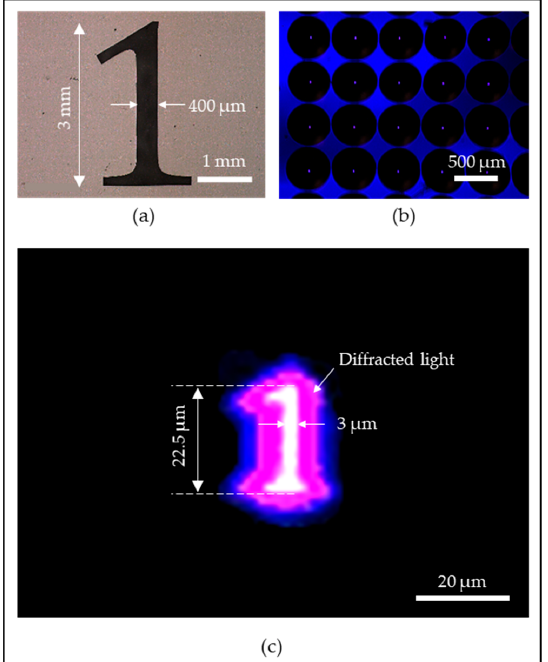
Figure 9. Real images generated by microlenses viewed by a microscope: ( a ) photomask pattern with number ‘ 1 ’; ( b ) mask pattern were imaged at the center of the MLAs; ( c ) close up view of the real image at the center of the microlens.